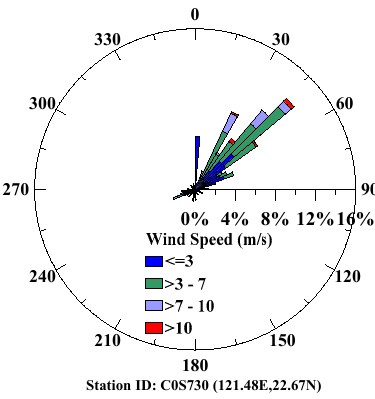
Figure 8. Wind rose chart for September 2010.